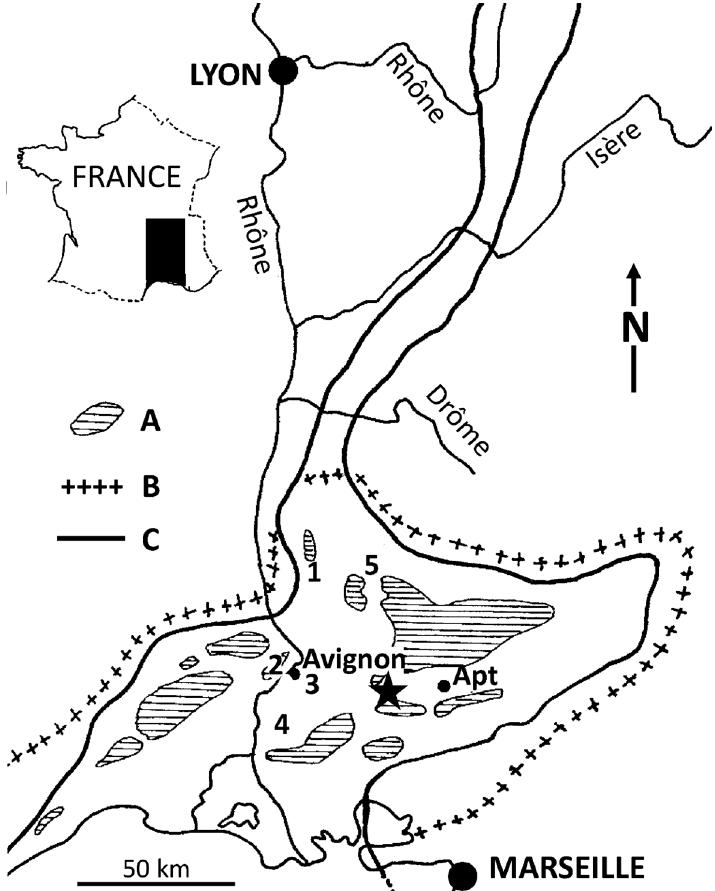
Fig. 1. The Miocene Rhône-Provence Gulf (modified from Philippe 1998: fig.1). A = submarine or emerging shoals; B = limit of the Rhône-Provence Gulf; C = estimated limit of the Burdigalian transgression. Sites with Discometra Gislèn, 1924 cited in the text are indicated as follows: black star = Ménerbes-Lacoste Plateau; 1 = Bollène; 2 = Les Angles; 3 = Caumont-sur-Durance (Picabrier); 4 = Notre-Dame du Château; 5 =